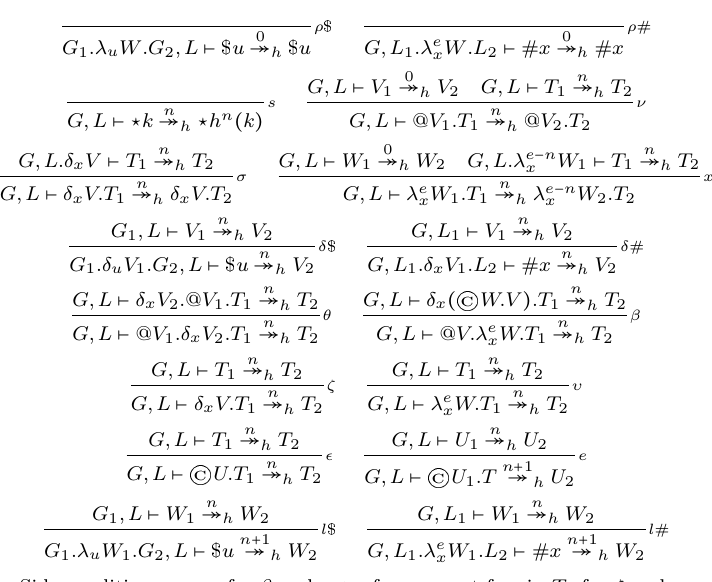
Fig. 4. The abstract syntax of terms and environments.